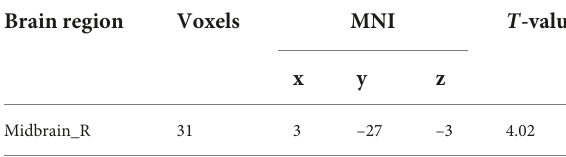
TABLE 3 Brain region showing increased functional connectivity with Ch_4 in insomnia